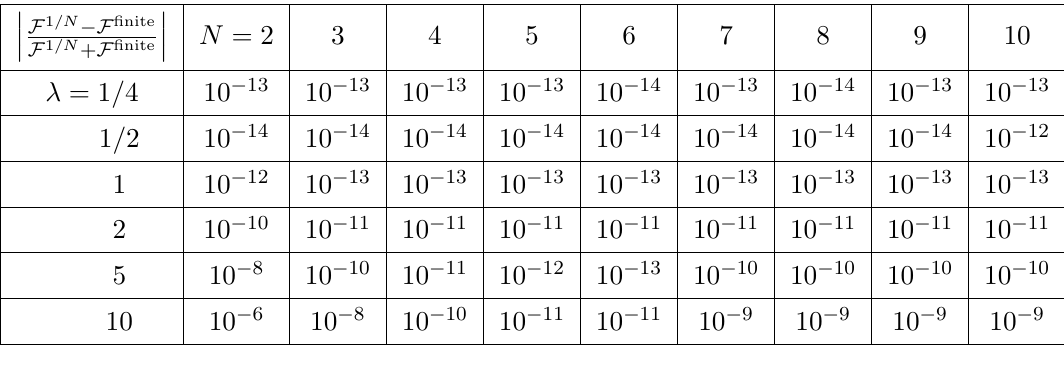
Table 1 . Comparison of the O ( N (cid:0) 6 ) expansion F 1 =N in (3.18) and (3.19) from topological recur- sion, and the (cid:12)nite N F (cid:12)nite for N = 2 ; : : : ; 10 from orthogonal polynomials. The 1 =N 2 expansion is most accurate for small g 2 = (cid:21)=N and large N YM